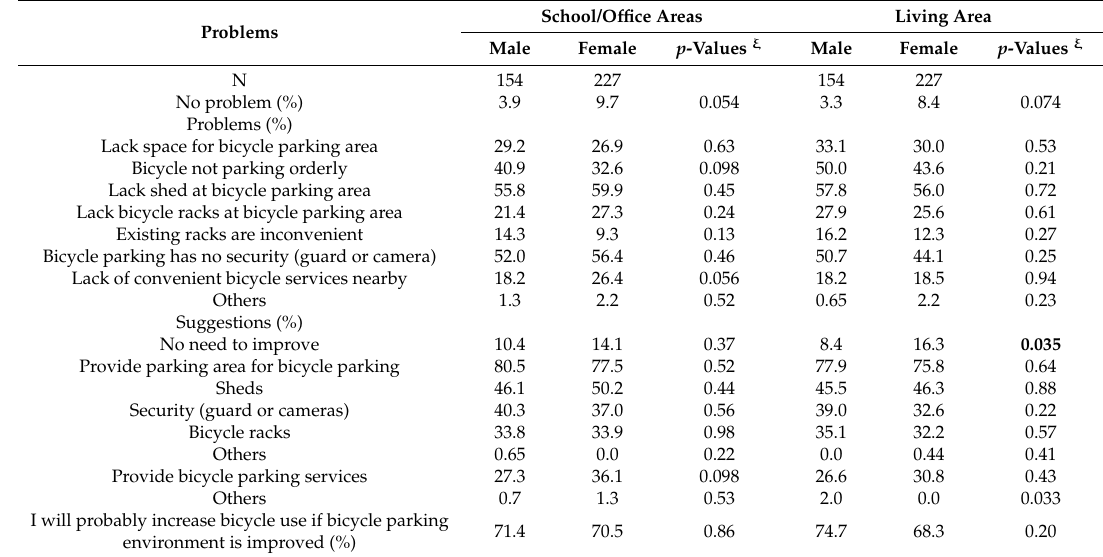
Table 3. Problems with and suggestions on how to improve bicycle parking environment on campus *. (N = 381). Problems